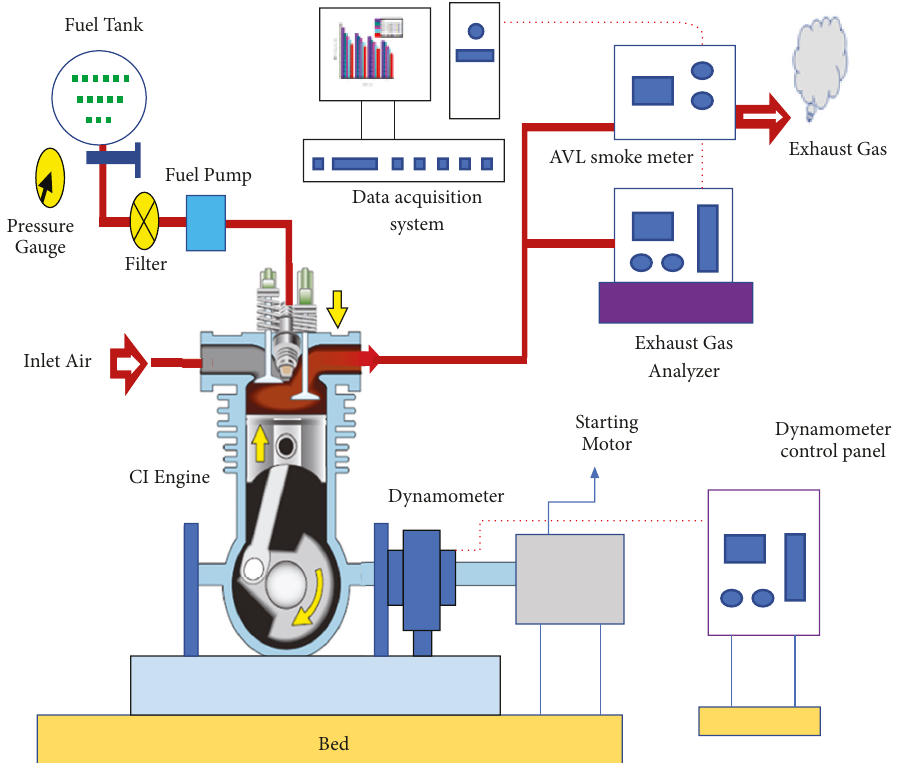
Figure 5: Schematic representation of the experimental